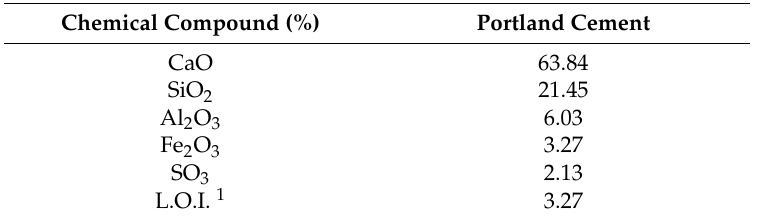
Table 1. Chemical composition of the Portland cement.